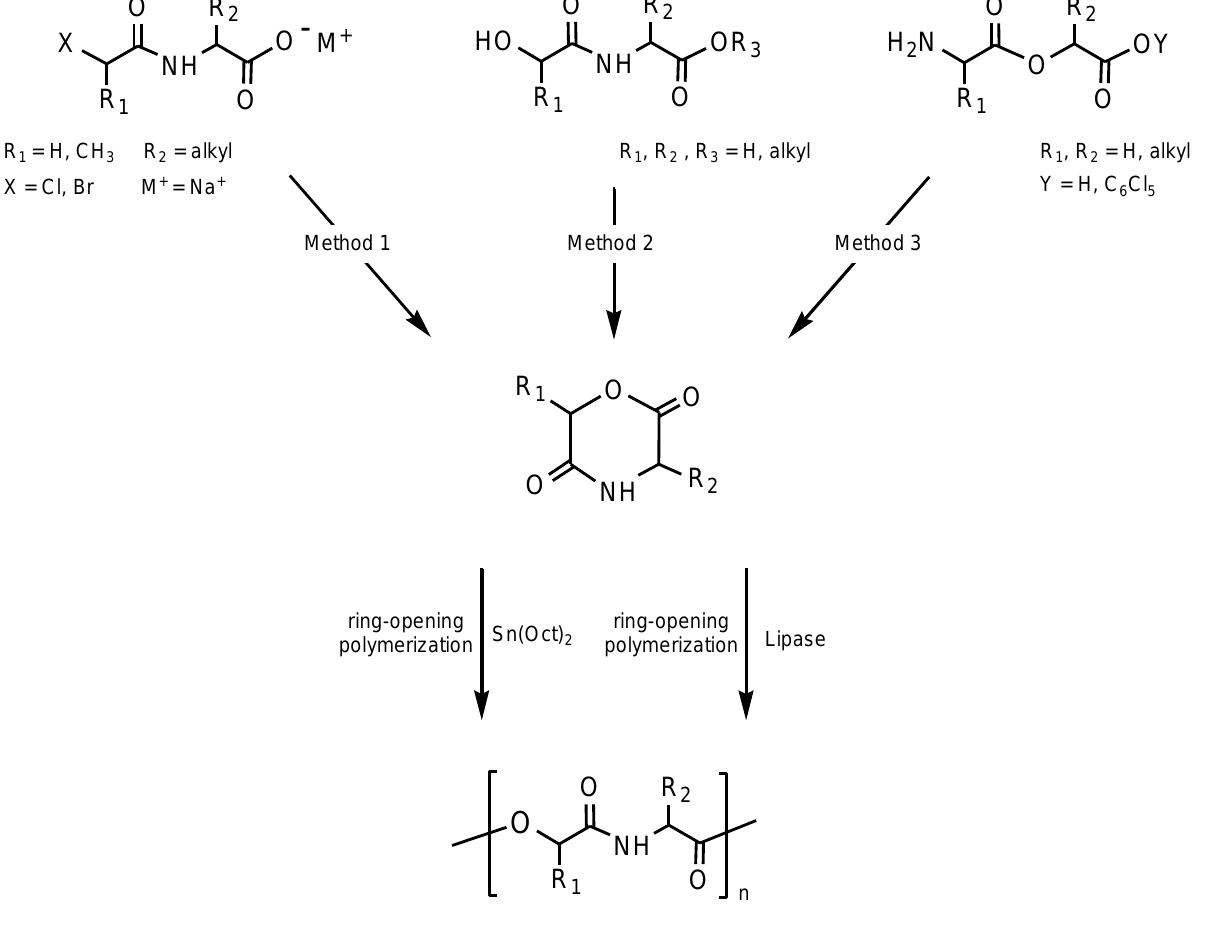
Figure 1. Synthesis of morpholine-2,5-dione derivatives and polymerization